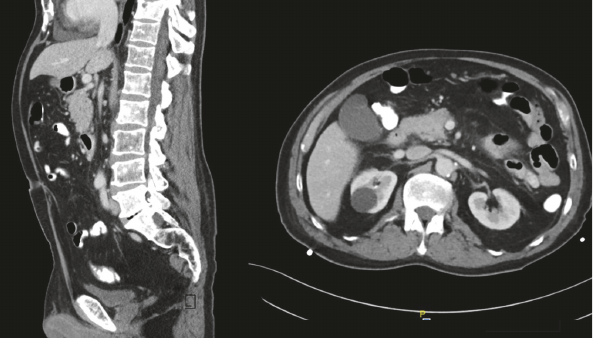
Figure 4: CT chest and abdomen/pelvis with contrast. Diffuse heterogeneousmarrowsignal of thethoracicspine and lumbar spine (left). Right kidney has several cysts with the largest measuring 2.8 x 2.9 cm (right). Findings were suggestive of diffuse osteopenia versus bony metastasis.